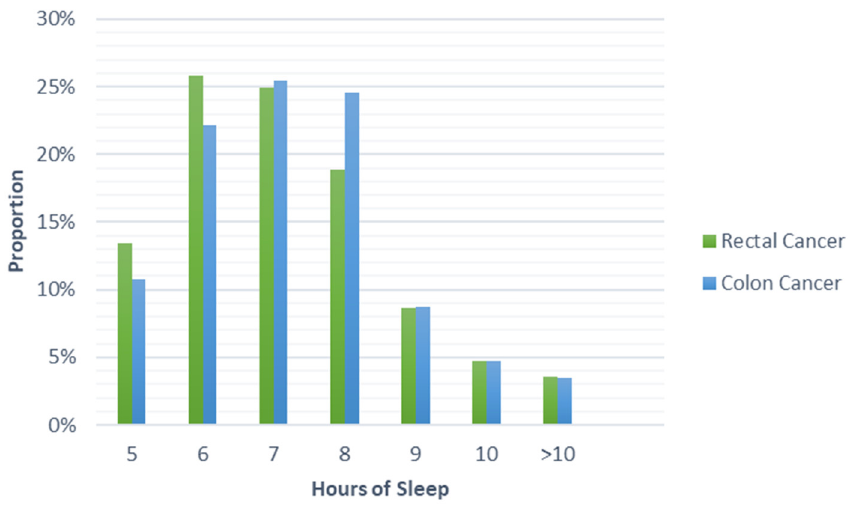
Figure 1. Proportion of cases reporting hours of sleep by colorectal cancer site.